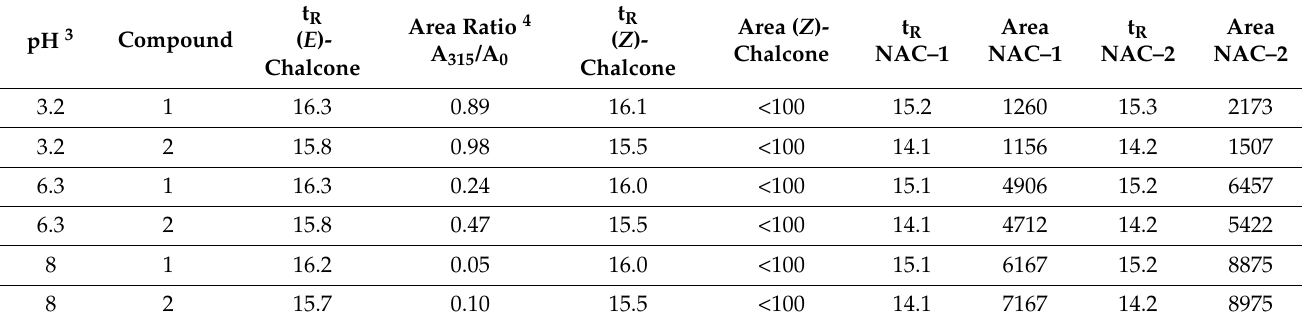
Table 2. Retention times (tr) 1 and integrated peak areas (A) of the investigated chalcones ( 1 and 2 ) and their NAC adducts 2 .